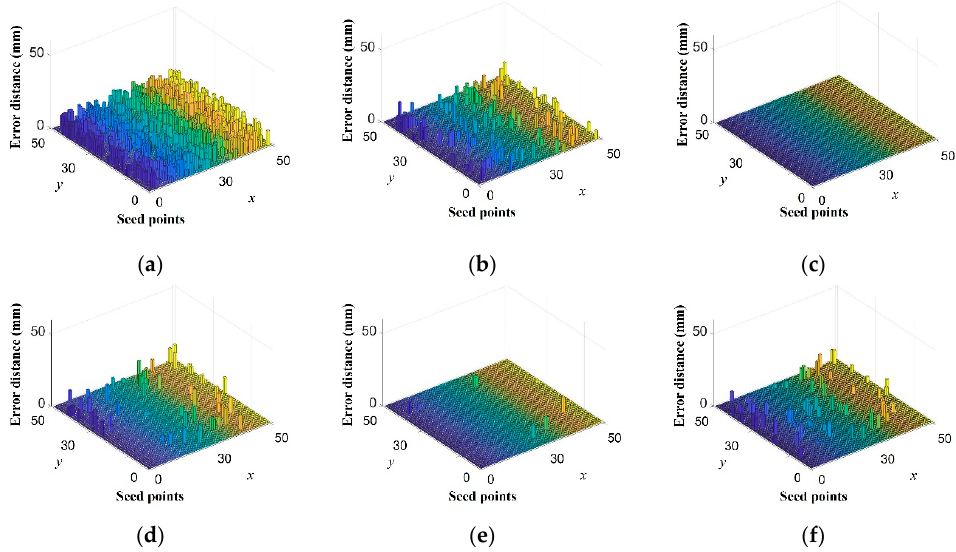
Figure 7. Validation test results of SSSIG: the subset size of 7 × 7 pixels with a horizontal displacement of ( a ) 200 μm, ( b ) 500 μm and ( c ) 1 mm. The subset size of 9 × 9 pixels with a horizontal displacement of ( d ) 200 μm, ( e ) 500 μm and ( f ) 1 mm. Table 1. Comparison of the number of spatial error points between the adaptive subset and the SSSIG. The Number of Spatial Error Points Case